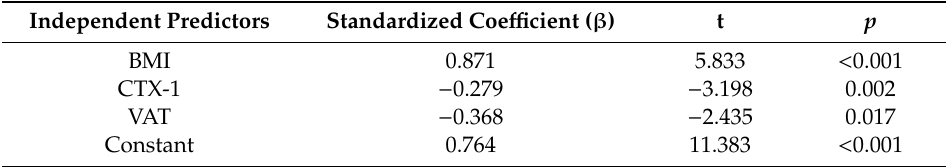
Table 6. Determinants of BMD—stepwise multivariate regression.